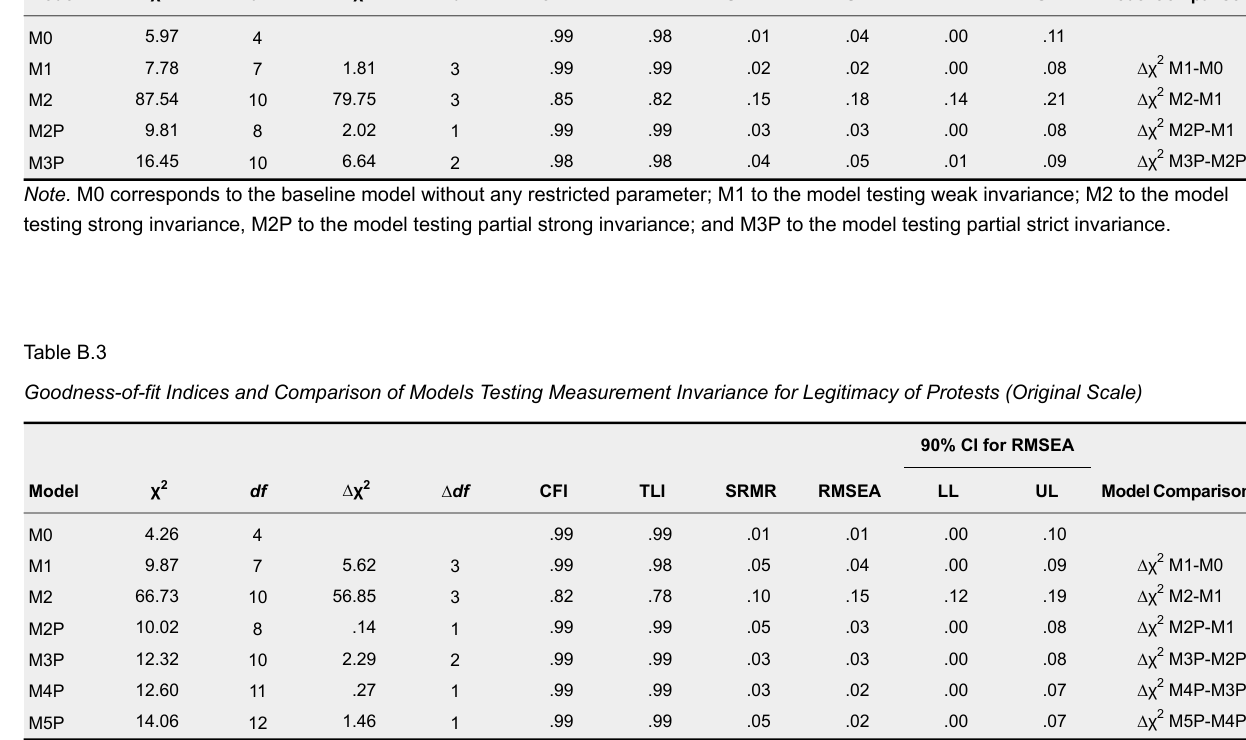
ModelComparison90% CI for RMSEA